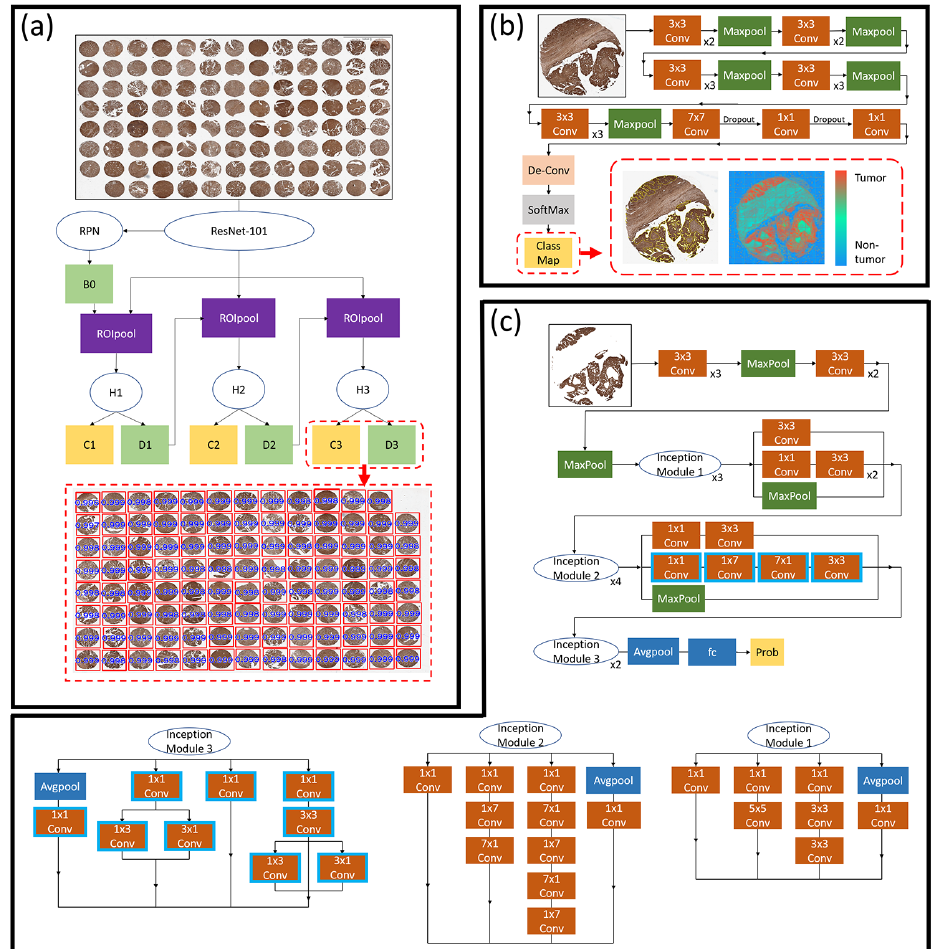
Figure 3. The proposed hybrid deep learning precision oncology framework contains three deep learning networks. ( a ) In the tissue core detection model, ResNet-101 backbone where RPN proposes a set of low quality candidate bounding boxes (B0) from an image to determine the occurrence of an object, and therefore the subsequent detectors are developed to be more selective for lower quality candidates. The modules (H) produced samples for training the z-th classifier and detector. Ref. [40] is used as the RPN ( b ) The proposed weakly supervised tumorlike tissue selection model composed of 16 convolution layers (each convolution layer is followed by a RELU layer), five pooling layers